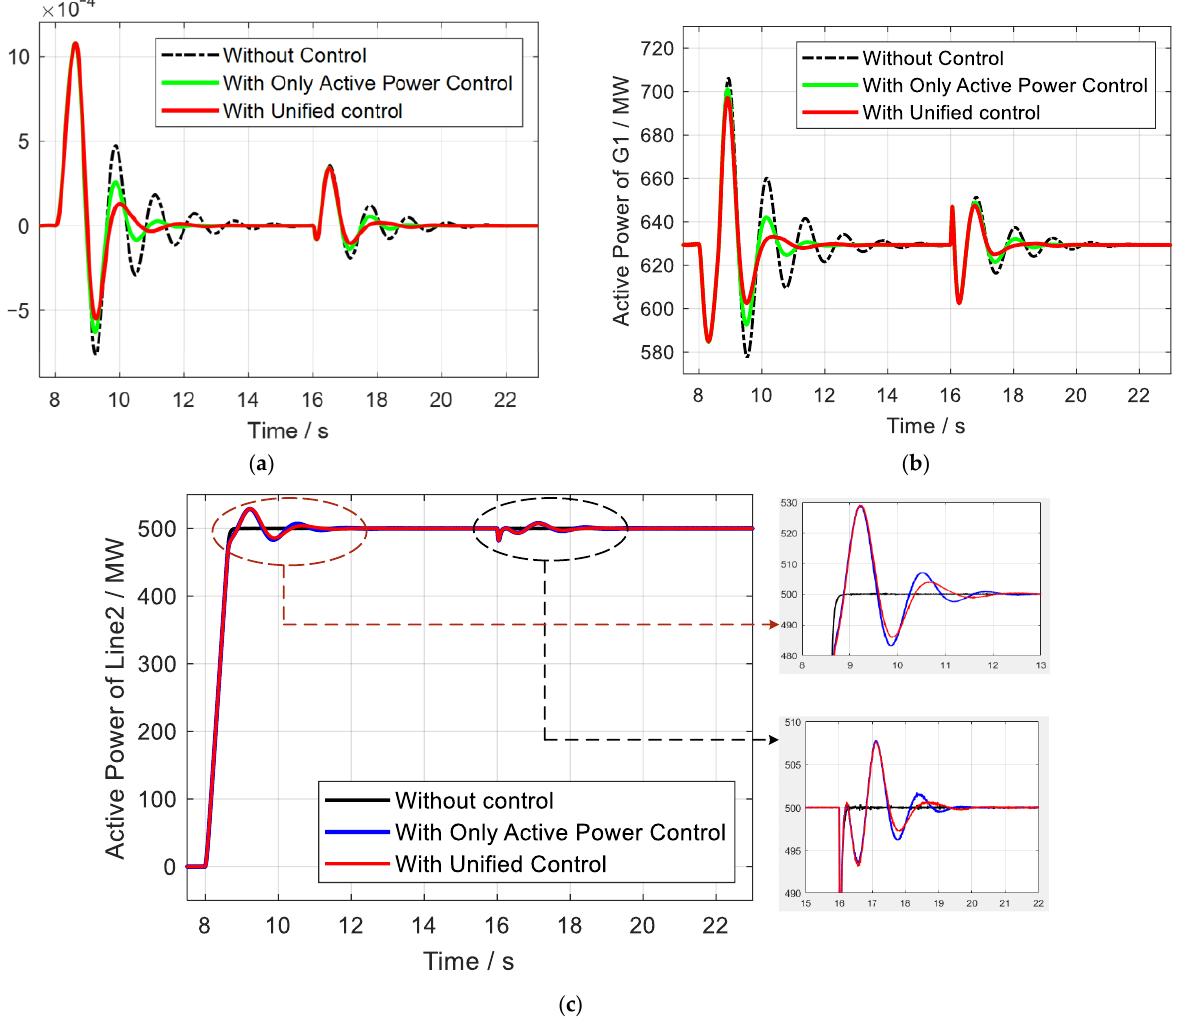
Figure 14. Simulation situations in case3. ( a ) The rotor speeds deviation of plant 1 with and without control in different situations. ( b ) The output active power of plant 1 with and without control in different situations. ( c ) The active power transmitted on Line 2 with and without control in different situations.